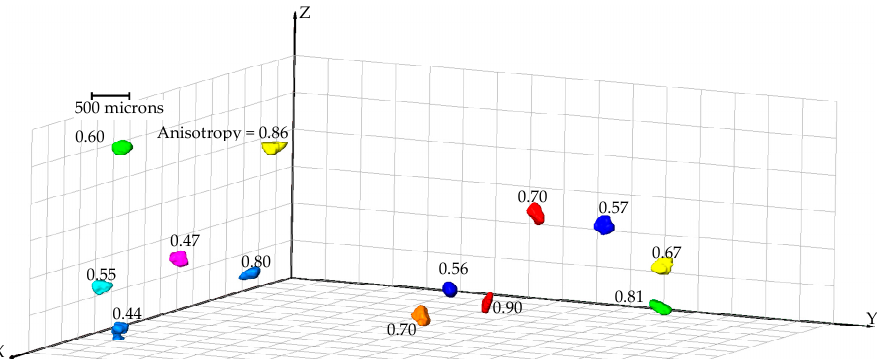
Figure 15. Variation of anisotropy of particles with equal volumes (6.3 × 10 6 cubic microns).